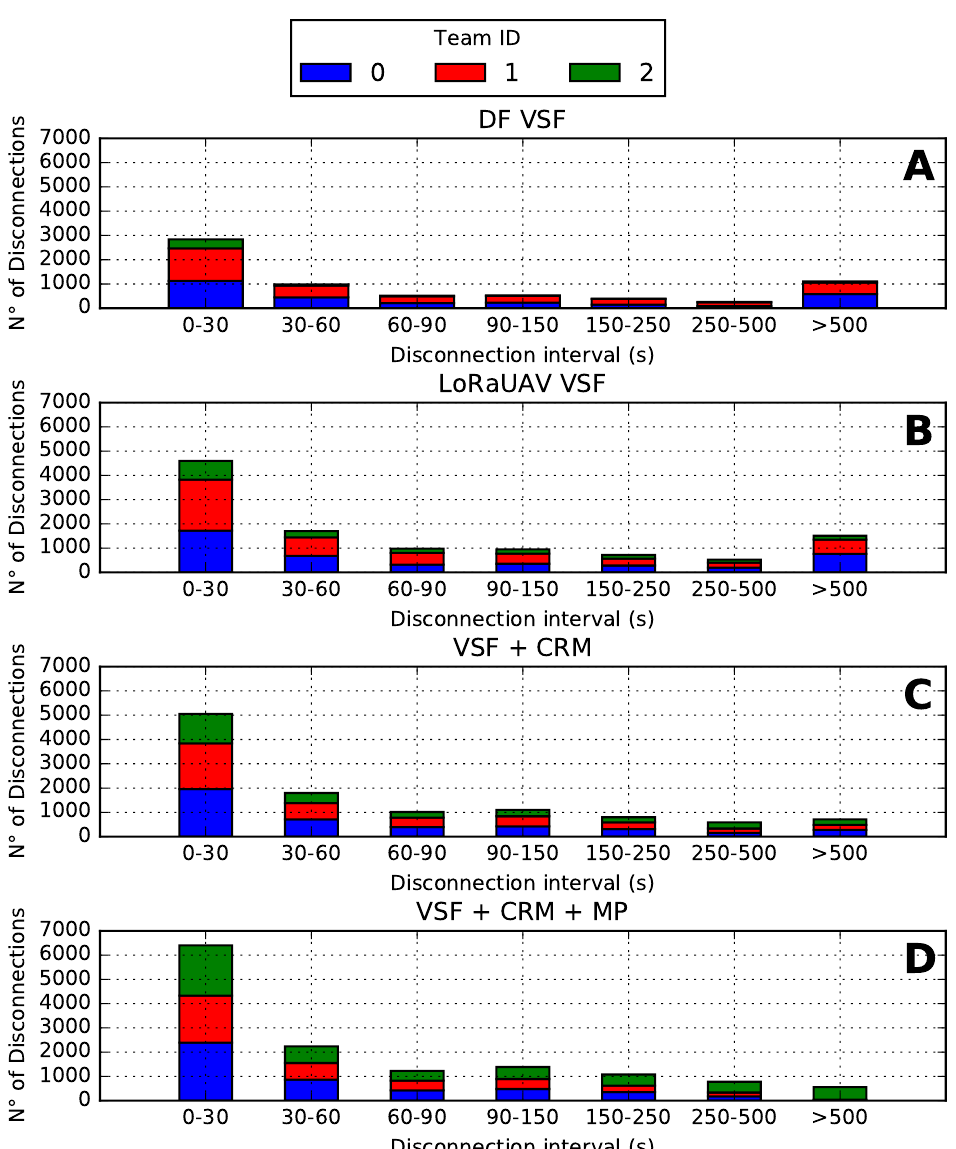
Figure 7. Frequency and duration of disconnections for DF VSF ( A ), LoRaUAV VSF ( B ), LoRaUAV VSF+CRM ( C ) and LoRaUAV VSF+CRM+MP ( D